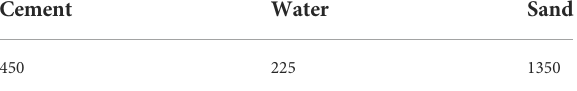
TABLE 1 M30 mortar matching ratio (g).